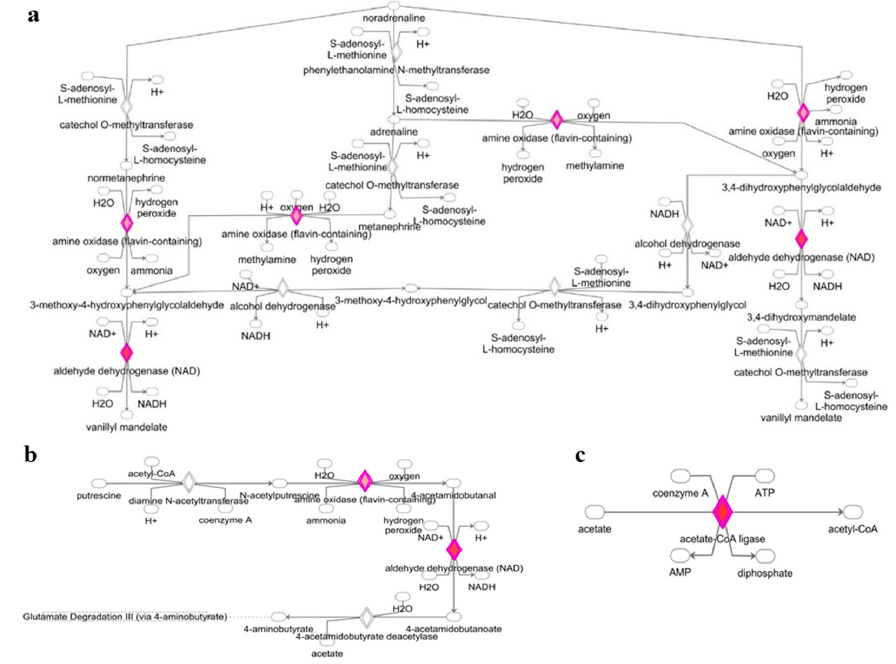
Figure 5. Alteration of biomolecule synthesis and degradation pathways in Rag2 KO mice ( a ) Upregulation of the noradrenaline degradation signaling; ( b ) Upregulation of the putrescine degradation pathway; ( c ) Upregulation of the acetate to acetyl-coA conversion signaling.